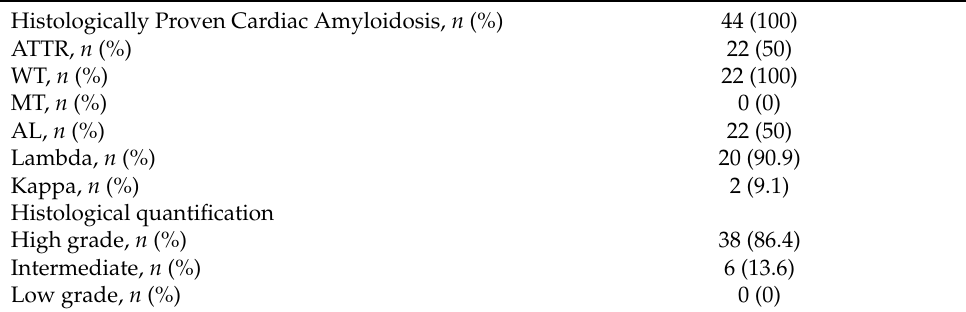
Table 4. Histology characteristics in cardiac